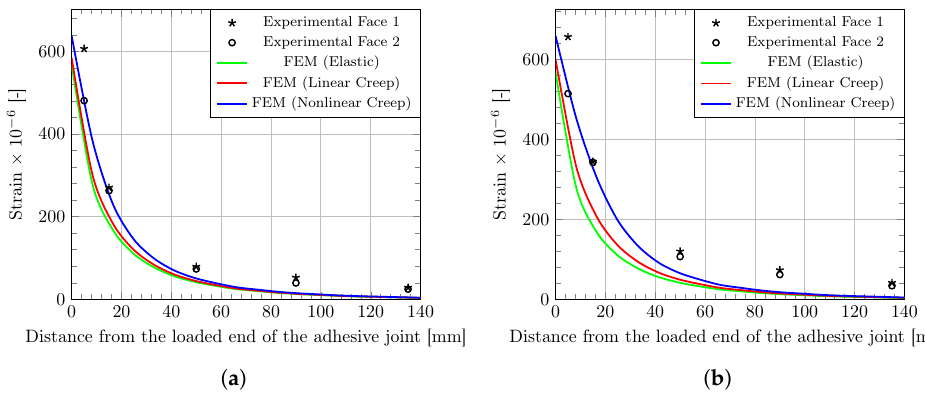
Figure 6. Axial strain ( (cid:101) xx ) profiles along FRP–concrete adhesive joint, ( a ) after the loading stage and ( b ) after an one-month creep period. Experimental data and simulations provided by the FE model considering different behaviors of the adhesive